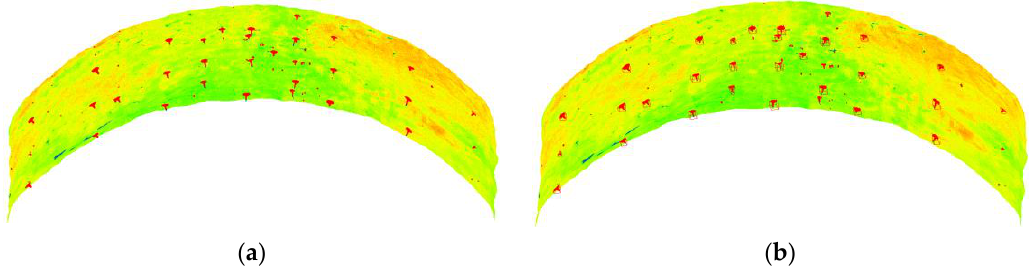
Figure 6. A neighborhood containing anchor rod points. ( a ) Initial point cloud after downsam- pling. ( b ) Preliminary identification results; points colored in blue are suspected anchor rod points. Figure 7. Suspected anchor rod points of initial identification. ( a ) Unclustered suspected anchor rod points in the test area. ( b ) Clustering results of suspected anchor rod points.